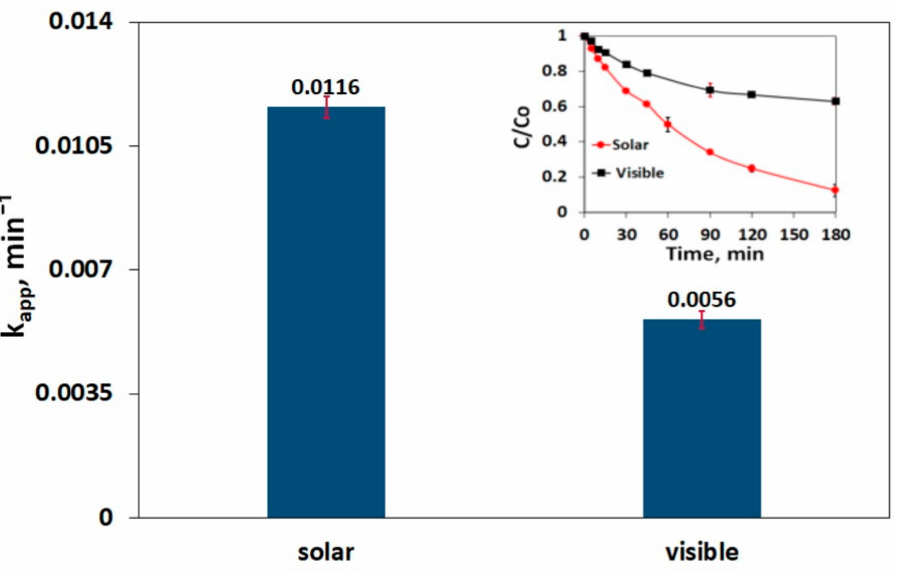
Figure 8. Effect of type of irradiation on the kinetics of SMX photodegradation and (Inset) on SMX photodegradation. [SMX]o = 500 µ g/L, [0.50 CoP/BVO] = 1000 mg/L, pH = 5.5,